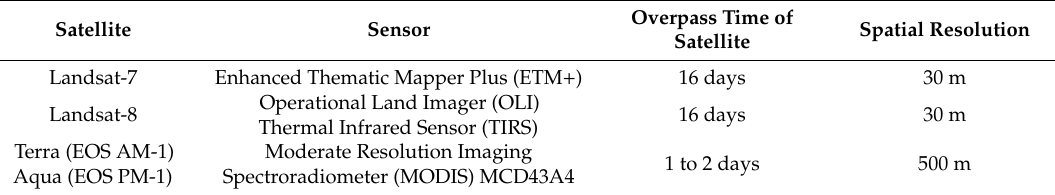
Table 1. Characteristics of satellites and sensors used in the study.